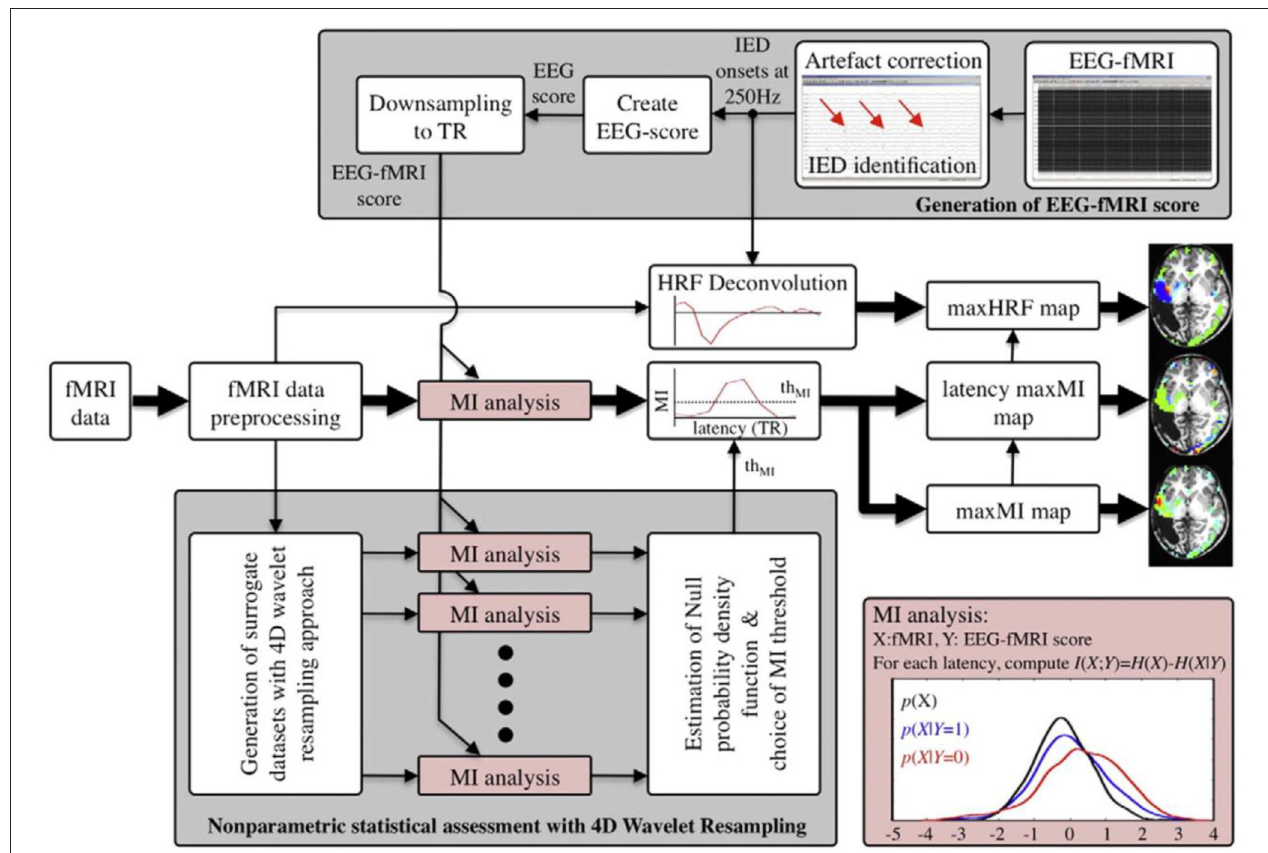
FIGURE 15 | Schematic diagram of the information-theoretic approach. The EEG recorded in the MR scanner is corrected for gradient and pulse artifacts. The time of occurrence of IED peaks is marked, and the EEG score indicating the existence of epileptic activity is created and finally downsampled to the temporal resolution of fMRI (TR) to generate the EEG–fMRI score (top gray-shaded square). The fMRI data is first preprocessed (rigid-body registration for motion correction, spatially smoothed, high-pass filtered, and z-normalized). The MI between the fMRI voxel time series and the EEG–fMRI score is computed based on the entropy and conditional entropy (bottom-right red-shaded square) at multiple latencies by shifting the EEG–fMRI score, resulting in an MI time course. The shape of the HRF is deconvolved based on the IED timing. Significant MI statistics are those exceeding a thresholded th MI , which is chosen according to the non-parametric statistical procedure where 19 surrogate datasets created with a 4D wavelet resampling approach are analyzed in the same way as the original dataset and the PDF of the MI statistics under the null is estimated (bottom gray-shaded square). To summarize the results, three maps are generated: a maximum MI map, a latency map showing the latency at which the maximum MI occurs, and a map plotting the amplitude of the HRF at the latency of the maximum MI (